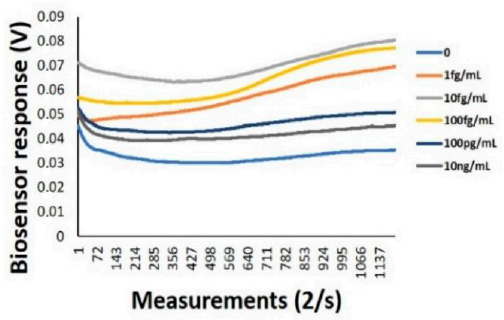
Figure 9. Biosensor response given by the variation of voltage in time for different concentrations of biomolecules [4] (licensed CC BY 4.0 from Sensors, 2020).